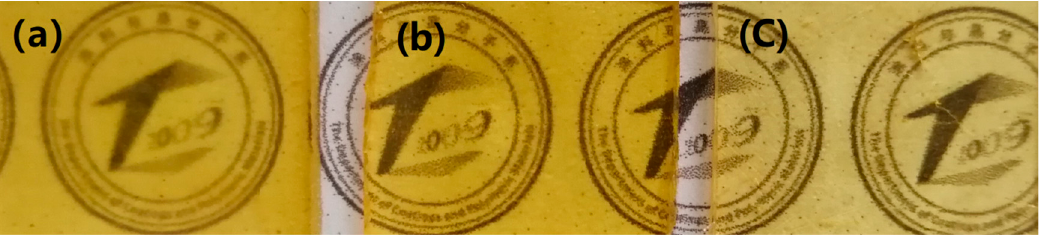
Figure 4. Pictures of the three films: the film prepared with hexamethylene diacrylate ( a ), trimethylolpropane diacrylate ( b ), and pentaerythritol tetraacrylate ( c ). Table 3. The films of different cross-linking multifunctional acrylates.